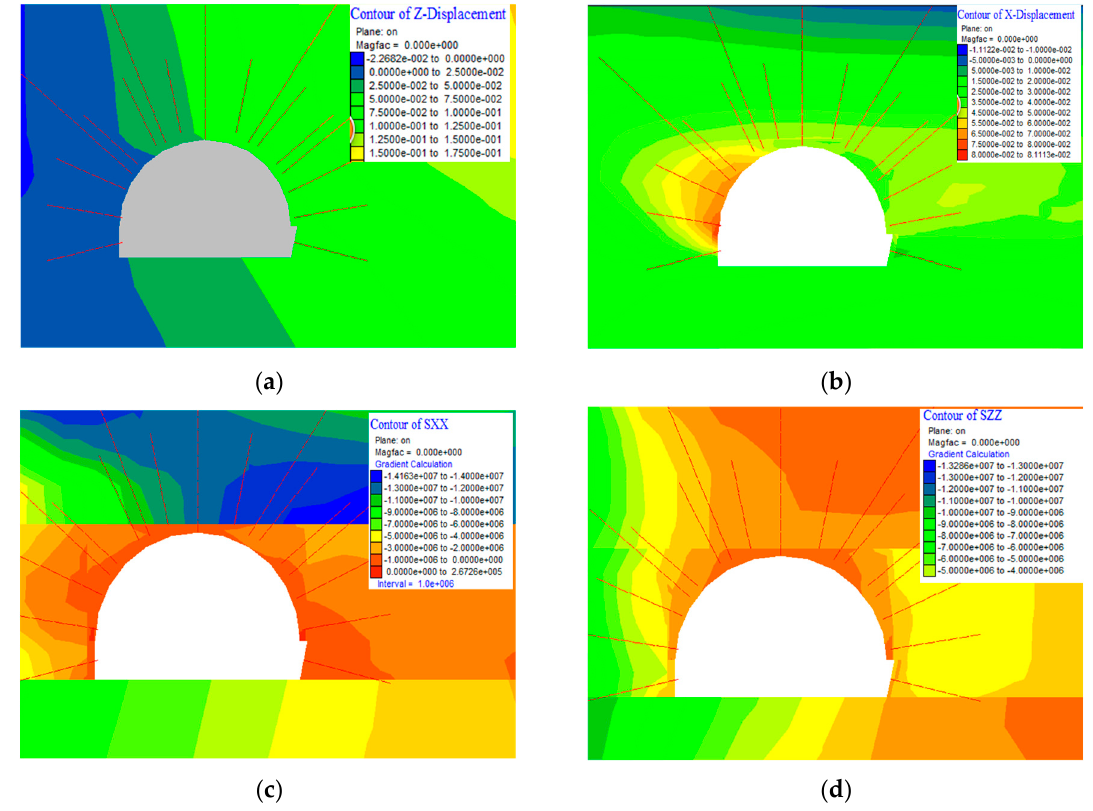
Figure 17. Stress distribution characteristics of floor after coal mining: ( a ) Vertical displacement; ( b ) Horizontal displacement; ( c ) Minimum principal stress; ( d ) Maximum principal stress.